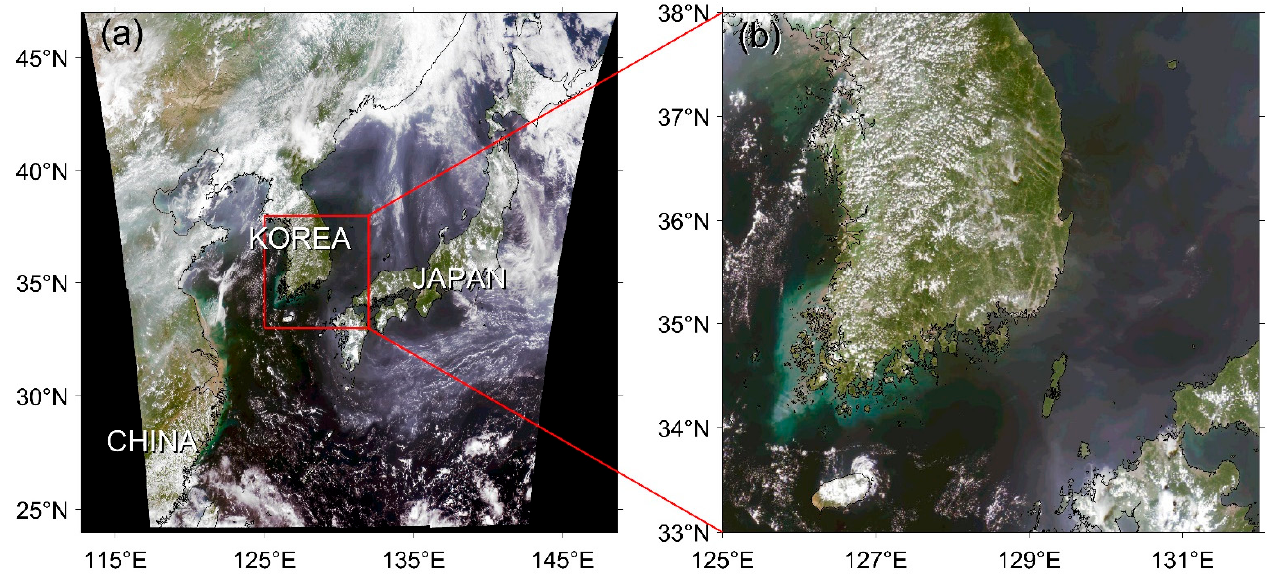
Figure 1. ( a ) Geostationary Ocean Color Imager (GOCI) red–green–blue (RGB) image of the research area on 13 August 2013, ( b ) enlarged image of red box in ( a ).